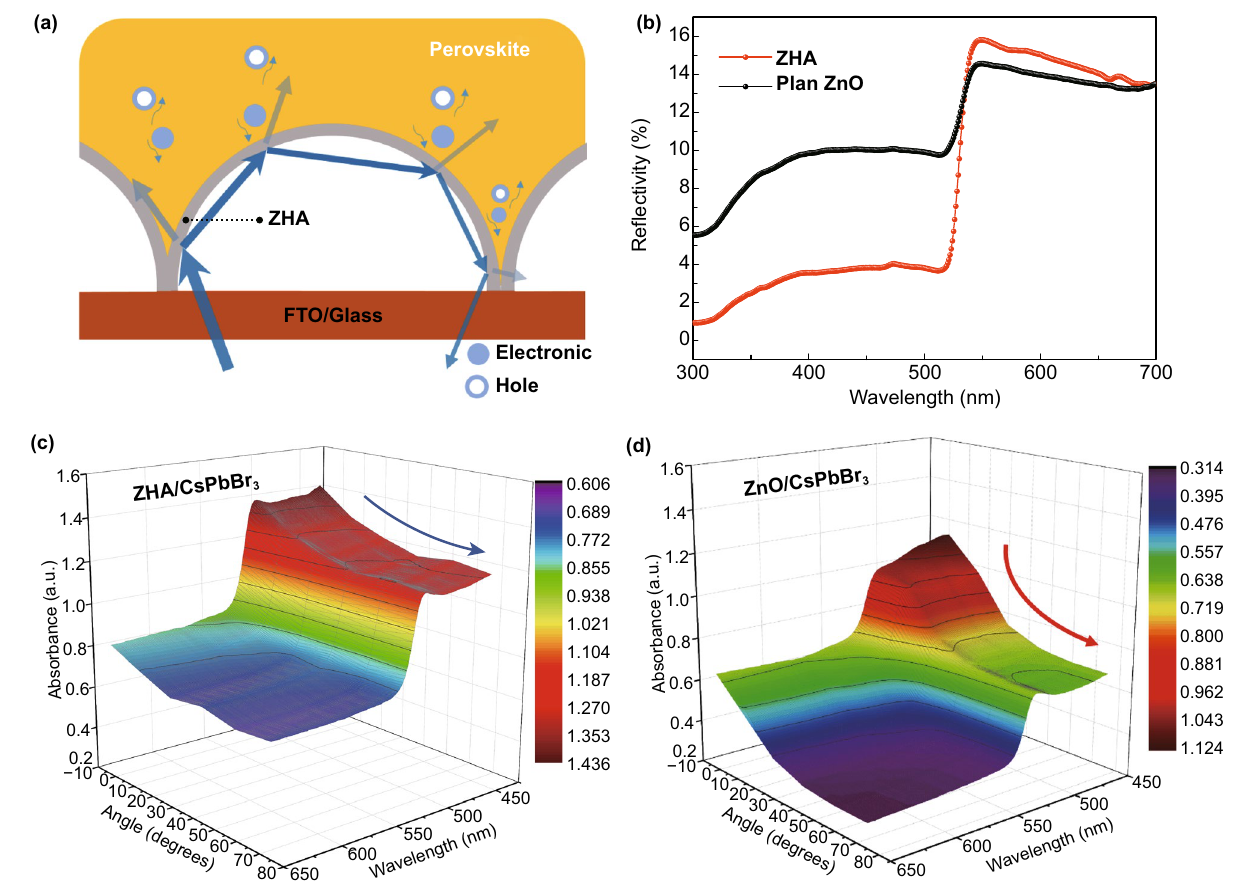
Fig. 2 a Schematic diagram of absorption and reflection of the ZHA/perovskite. b Light reflectivity curves of the ZnO/CsPbBr 3 and the ZHA/ CsPbBr 3 . Light absorbance of c ZHA/CsPbBr 3 and d ZnO/CsPbBr 3 with variable incident angles of the